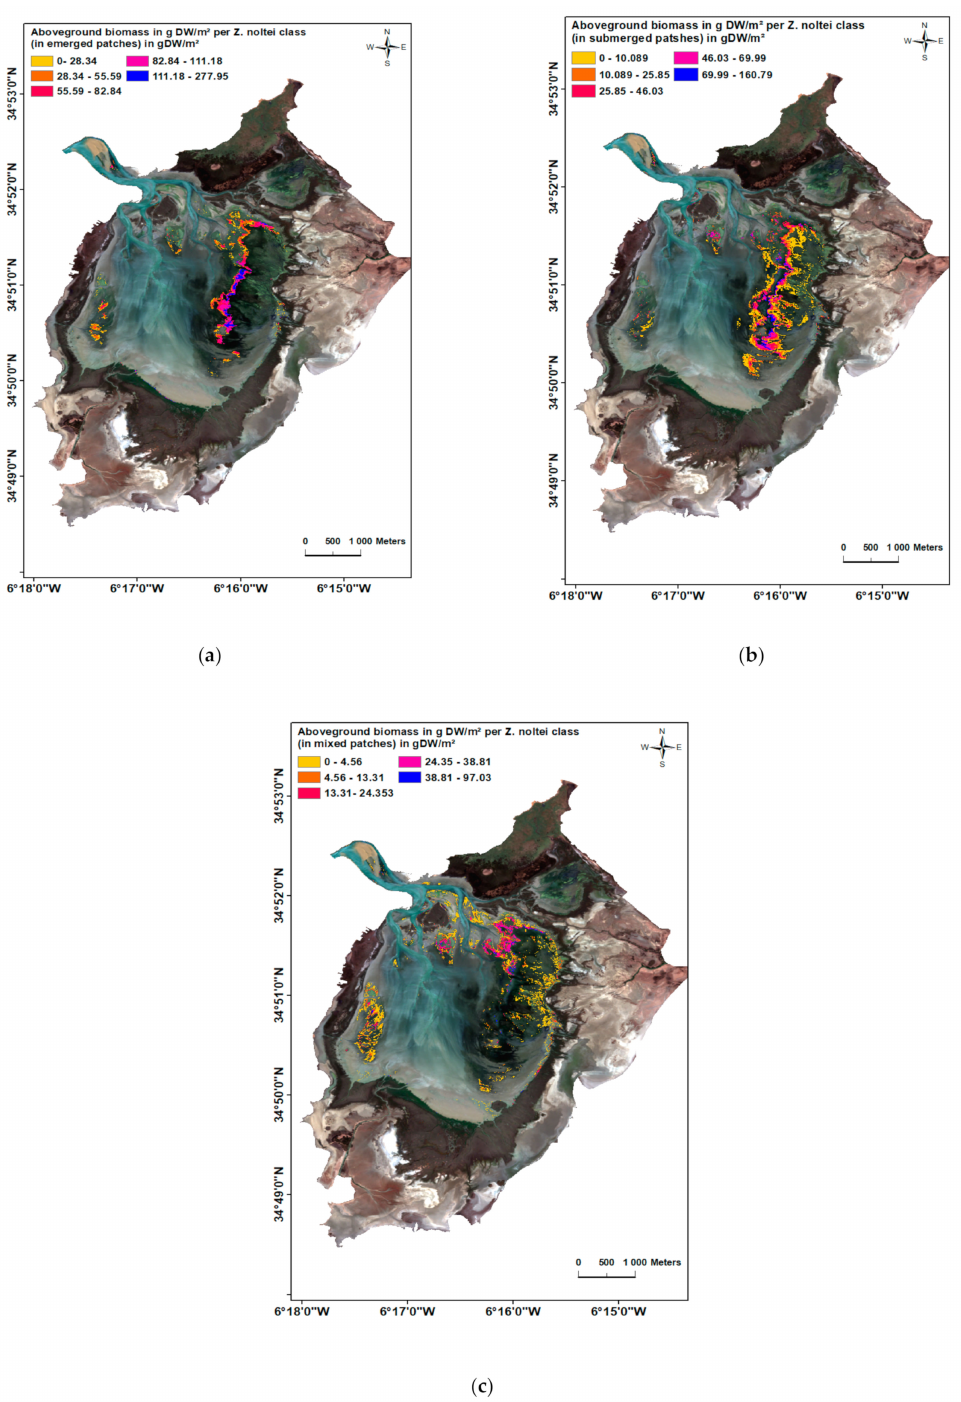
Figure 8. Aboveground biomass in g DW/m 2 per Z. noltei class ( a – c ) in the Merja Zerga